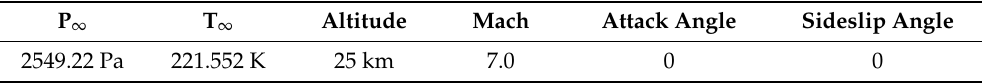
Table 4. Free-stream flow conditions of shroud separation. P ∞ T ∞